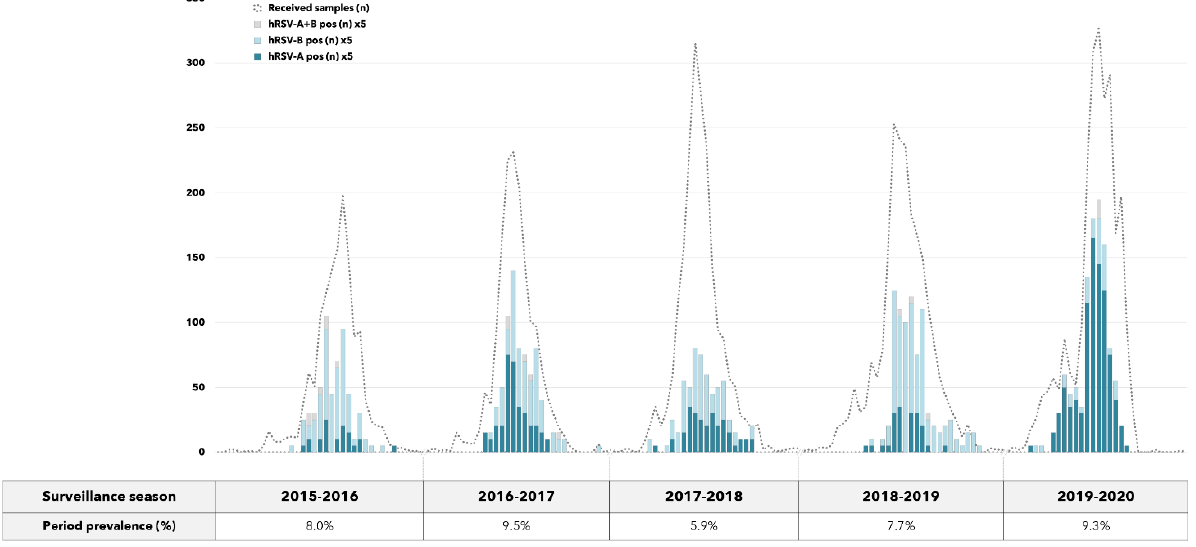
Figure 2. Seasonal distribution of hRSV-A and hRSV-B detected in patients with acute respiratory infections between 2015–2016 and 2019–2020. For purely graphical reasons, inter-seasonal periods were removed and the number of hRSV- positive samples multiplied by a factor of 5.